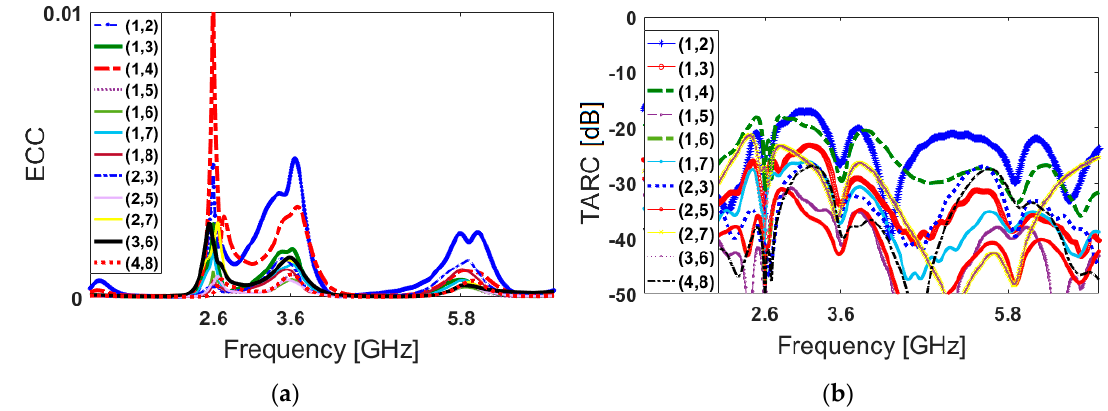
( c ) Figure 10. ( a ) Front and ( b ) back views, and ( c ) feeding mechanism of the fabricated sample. The measured and simulated results of the S-parameters are compared in Figure 11a. As seen, the S 11 /S 21 measurements have good agreement with the simulated results in terms of covering the required multi-operation bands: a quite good impedance bandwidth (S 11 < − 10) is achieved to cover the operation bands of 2.45–2.65 GHz, 3.5–3.7 GHz and 5.6–6 GHz with resonances at 2.6, 3.6, and 5.8 GHz, respectively. In addition, as shown, the mutual couplings of the adjacent PIFAs are less than − 15, − 10, and − 13 dB at the desired frequency bands. One of the vital parameters for the MIMO performance of an antenna array is diversity gain (DG), which can be calculated using the following formula: